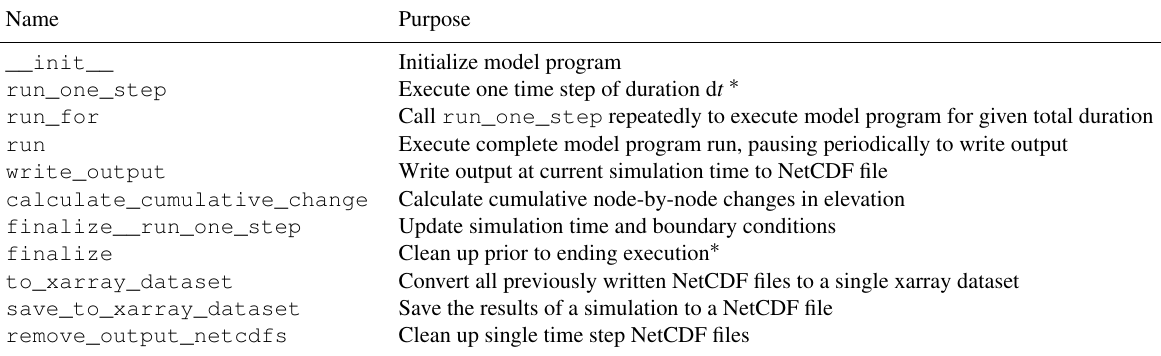
Table 3. Public base class